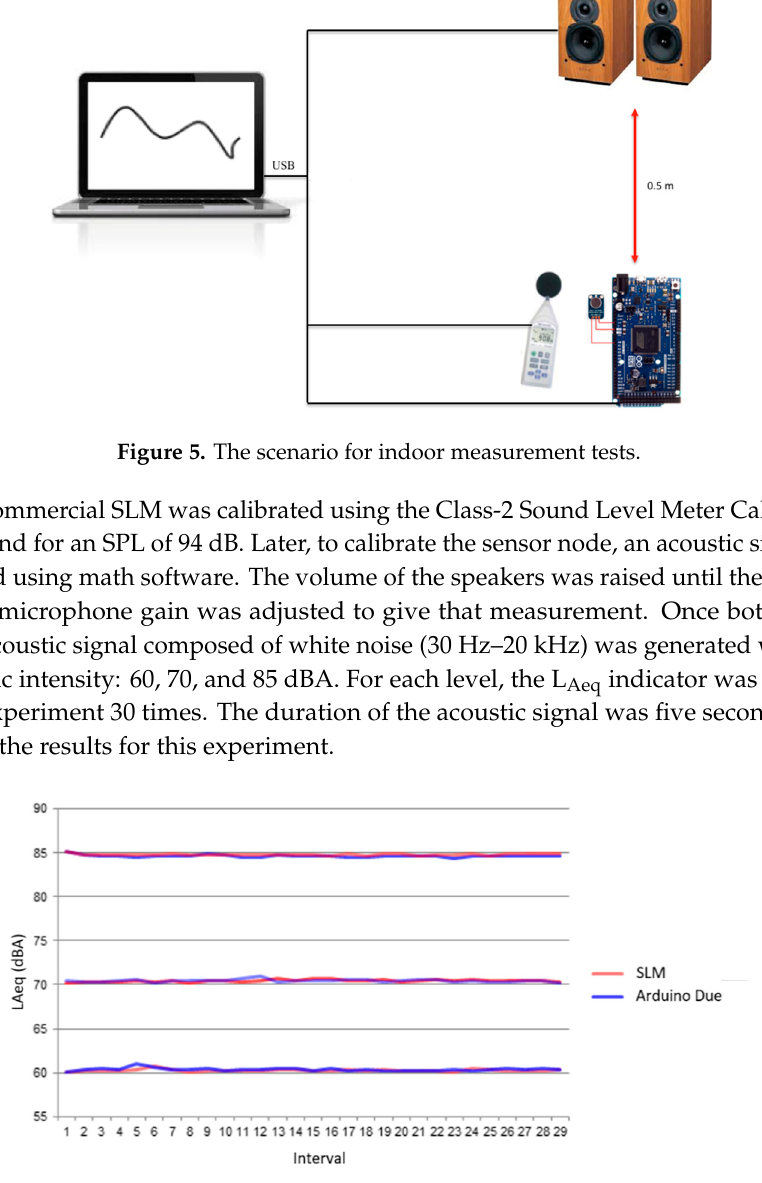
Figure 6. The white noise lab tests.